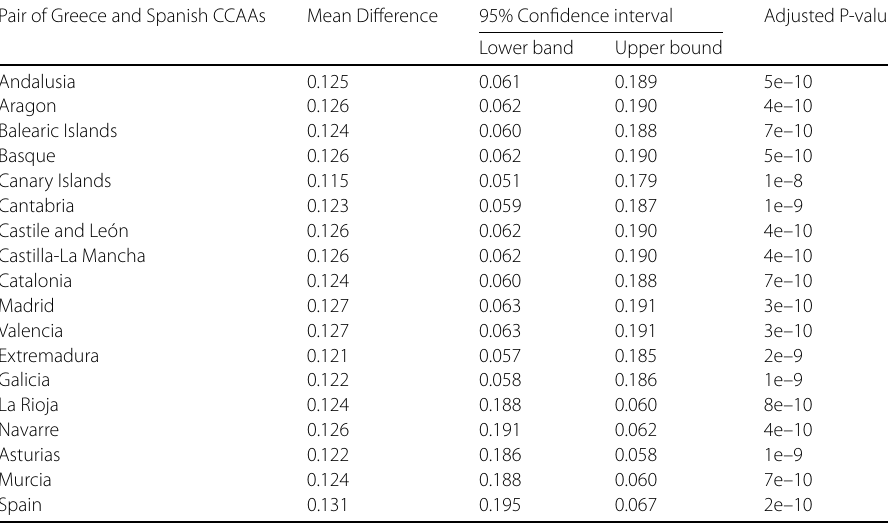
Table 15 HSD Tukey test results filtered by for the pair of CCAAs-countires which include Greece Pair of Greece and Spanish CCAAs Mean Difference 95% Confidence interval Adjusted P-value Lower band Upper bound Andalusia 0.125